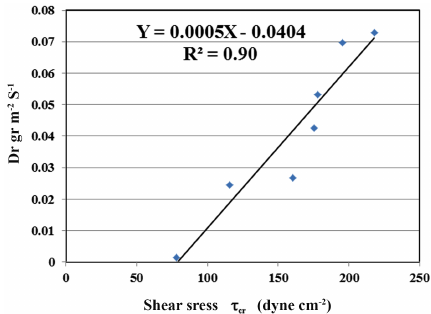
Figure 6. Relationship between shear stress ( τ ) and detachment rate in abandoned land ( P <